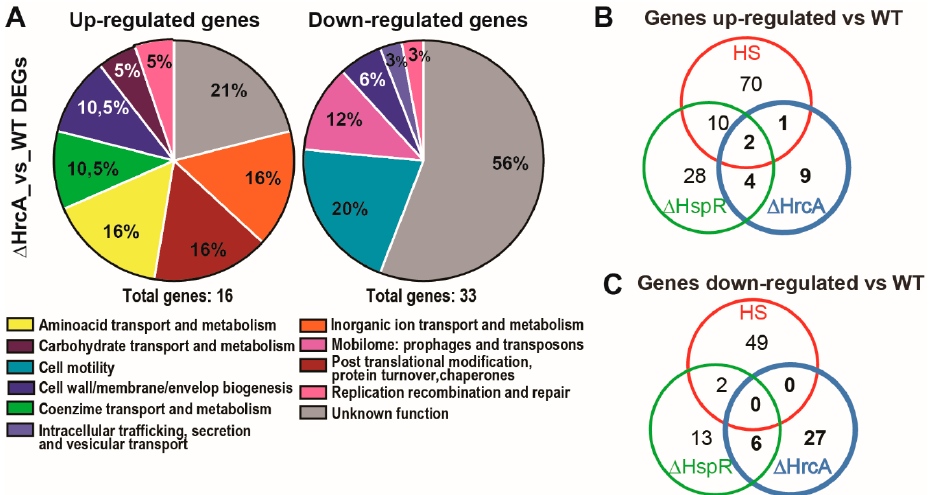
Figure 2. Analysis of the HrcA regulon and its integration with HspR-mediated regulation and general heat-shock response. ( A ): Pie charts showing COGs functional annotation of the differentially expressed genes outlined in the Δ hrcA _vs_WT comparison subdivided into up-regulated (left) and down-regulated (right) groups. The abundance of each category is indicated as a percentage, while the total number of up- and down-regulated genes is reported below each chart. ( B ) and ( C ): Venn diagrams showing the number of coherently up-regulated ( B ) or down-regulated ( C ) genes specific of the HrcA regulon or in common with the HspR and/or the heat-shock dataset (according to [9]).